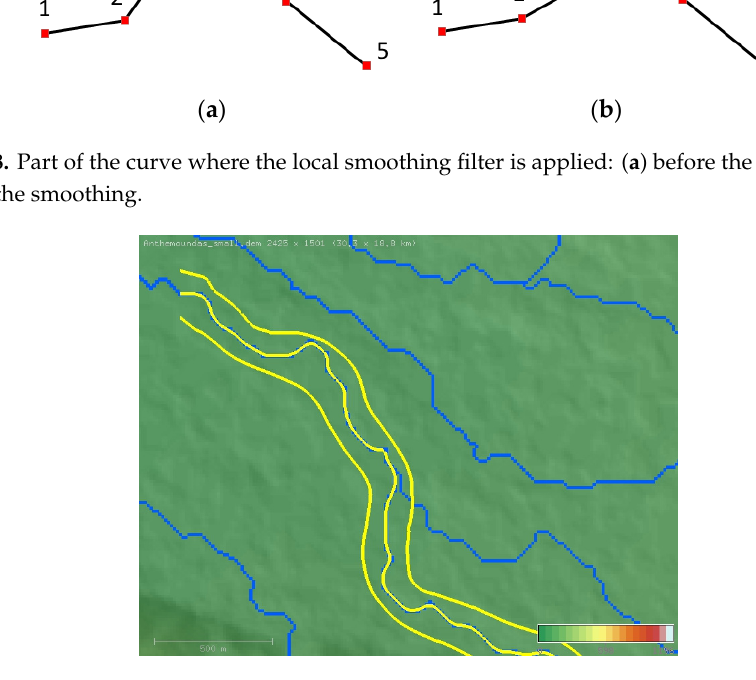
Figure 19. The stream curve and the bank curves on the Digital Elevation Model’s (DEM’s) plan view.